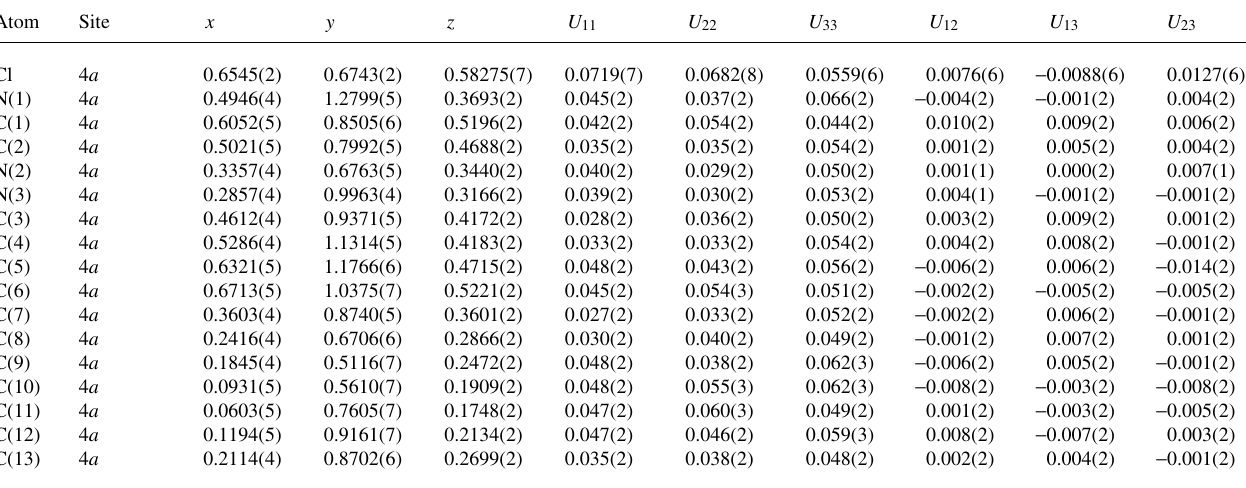
Table 3. Atomic coordinates and displacement parameters (in Å 2 )